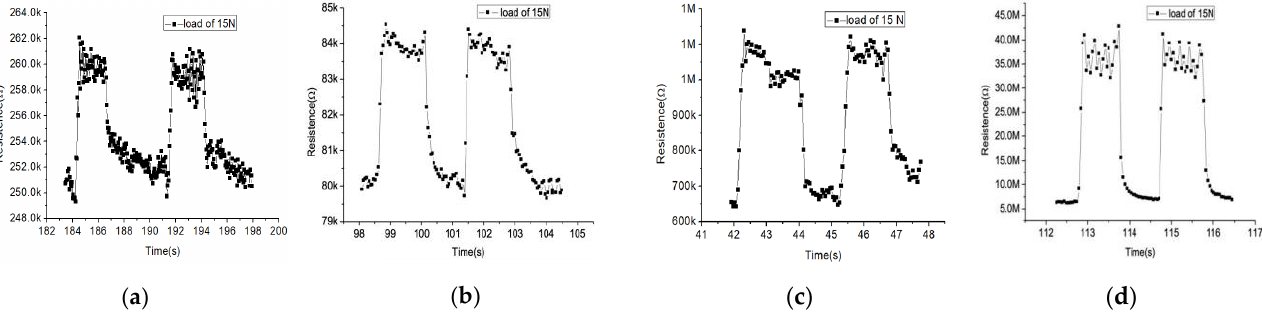
Figure 9. Response and recovery time of the pressure sensor with 8 wt% MWCNTs and LC of ( a ) 0 wt%; ( b ) 20 wt%; ( c ) 40 wt%; and ( d ) 60 wt%.